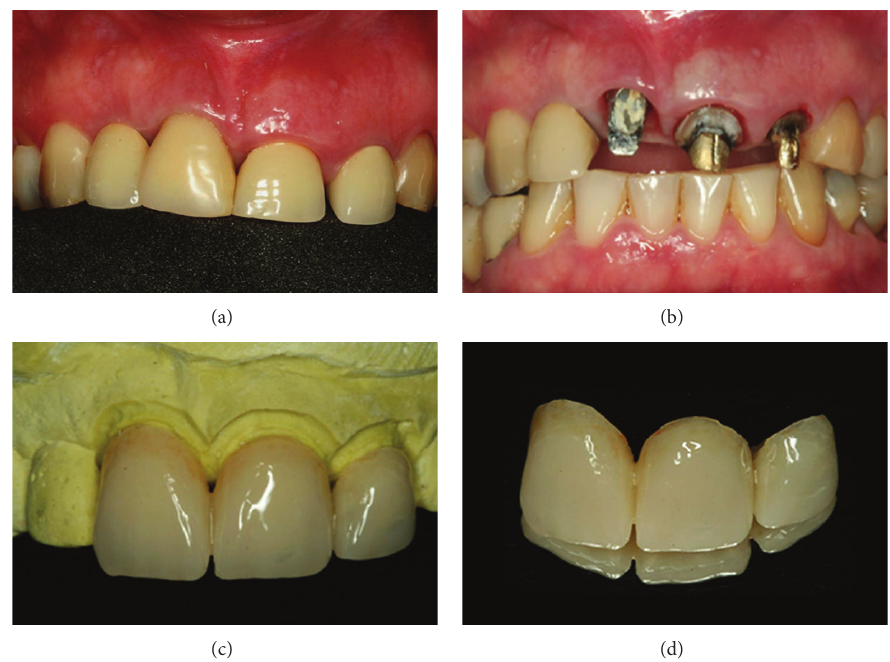
Figure 4: (a) Uneven gingival level of the maxillary right central incisor. (b) After removal of the provisional crown. (c, d) New provisional resin crown to favor the gingival